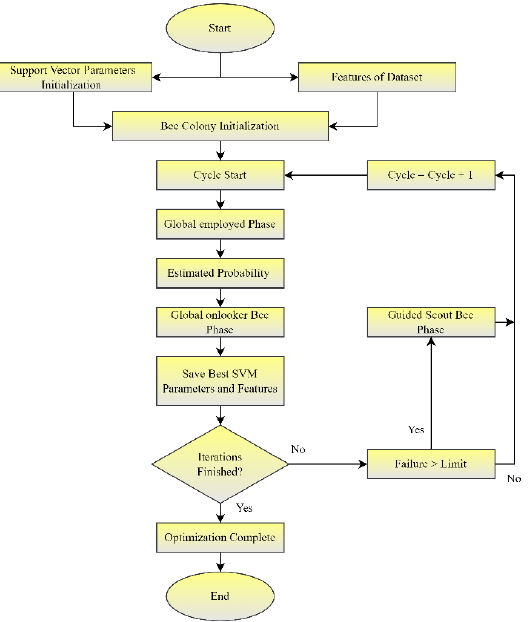
Figure 7. ACO ‐ SVM Algorithm. Figure 7. ACO-SVM